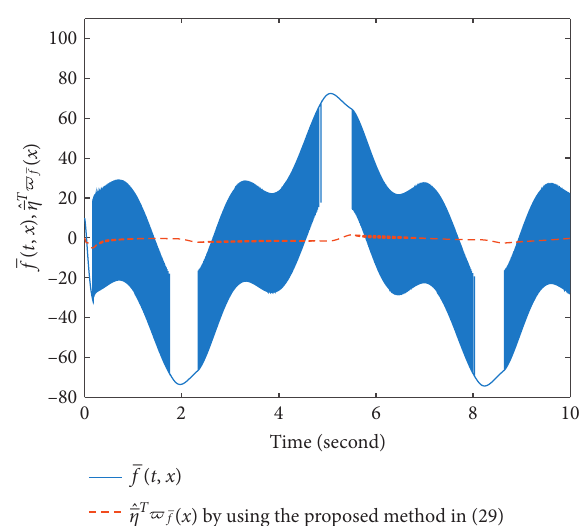
Figure 3: Trajectories of f ( t,x ) and 􏽢 η T ϖ in